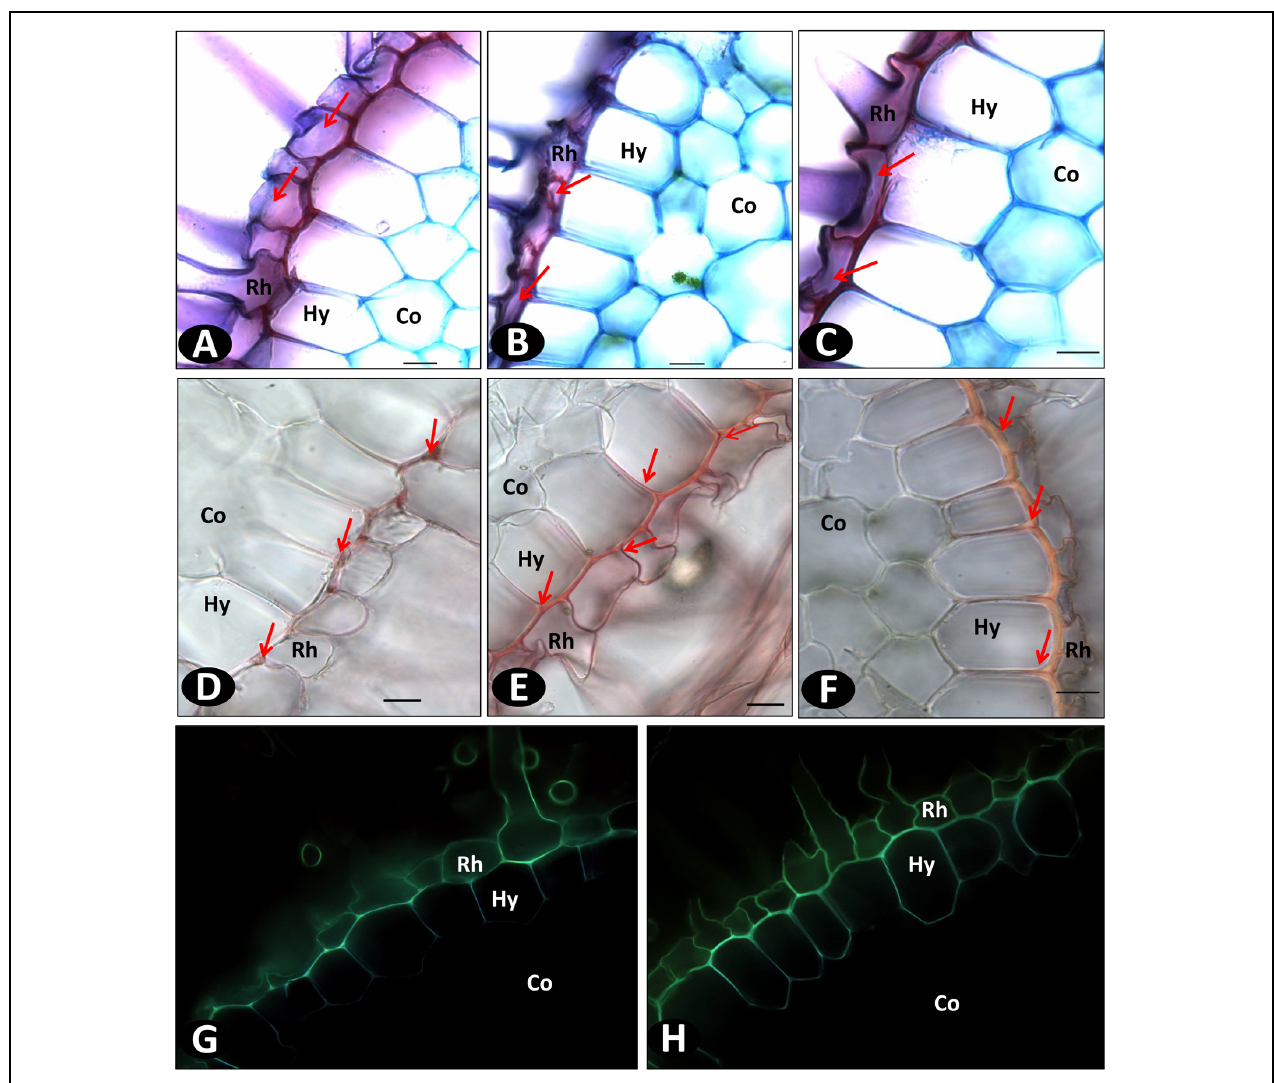
FIGURE 8 | Wide field microscopy images of non-inoculated in vitro roots showing the difference in the cell wall structure and compositions using different staining methods. (A–C) FASGA stained transverse section of roots showing the round shaped rhizodermal (Rh) cells (denoted with arrows) in pla0001 (A) and compact rhizodermal cells in pla0020 (B) and pom0018 (C) ; (D–F) Transverse sections of vanilla in vitro roots stained with phloroglucinol. Discontinuous lignin deposition mostly localized as small patches (denoted with arrows), without radial thickenings, on the hypodermis (Hy) of pla0001 (D) , contrary to pla0020 (E) , and pom0018 (F) showing continuous longitudinal and radial deposition of lignin on the longitudinal and radial walls of hypodermis. (G,H) displays the differences between susceptible pla001 (G) and resistant pom0018 (H) in the composition of rhizodermal and hypodermal cells stained with berberine hemisulfate which has affinity to suberin and lignin. Co: Cortex. Scale bar = 20 μ